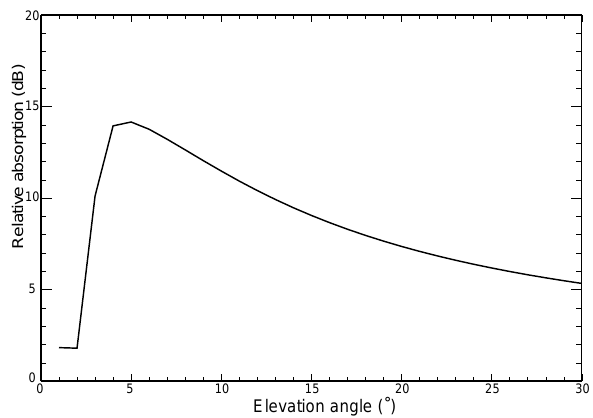
Fig. 7. A calculation of the difference in the expected absorption of the Hankasalmi HF signal before and after the substorm expansion phase onset, as a function of the radar angle-of-arrival. See text for